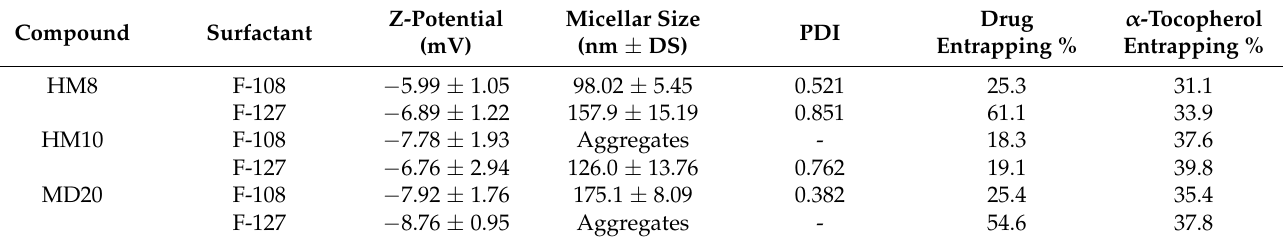
Table 2. Characteristics of the Pluronic micellar solutions loaded with 5% α -tocopherol.